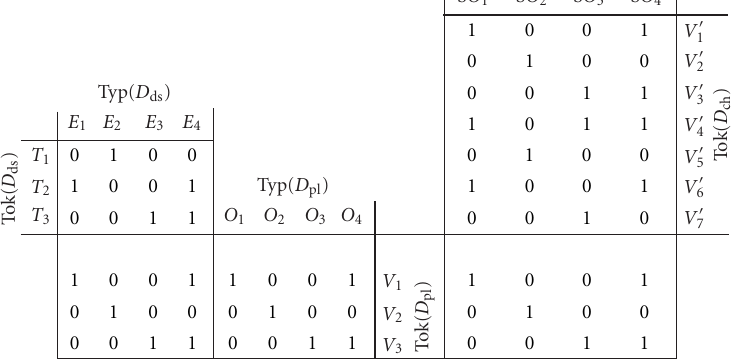
Figure 6: A description of a “playing structure design” by Chu